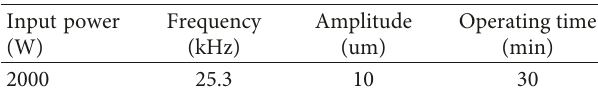
Figure 3: Schematic diagram and photo of ultrasonic casting. Table 2: The key parameters of ultrasonic device.